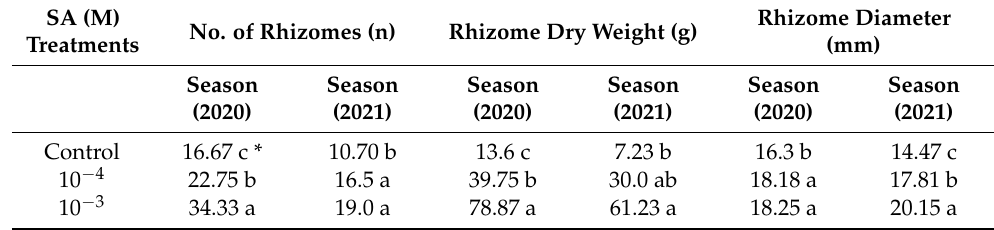
Table 5. Effects of SA treatment on the number (n) of rhizomes, rhizome dry weight, and rhizome diameter (mm) of C. longa .